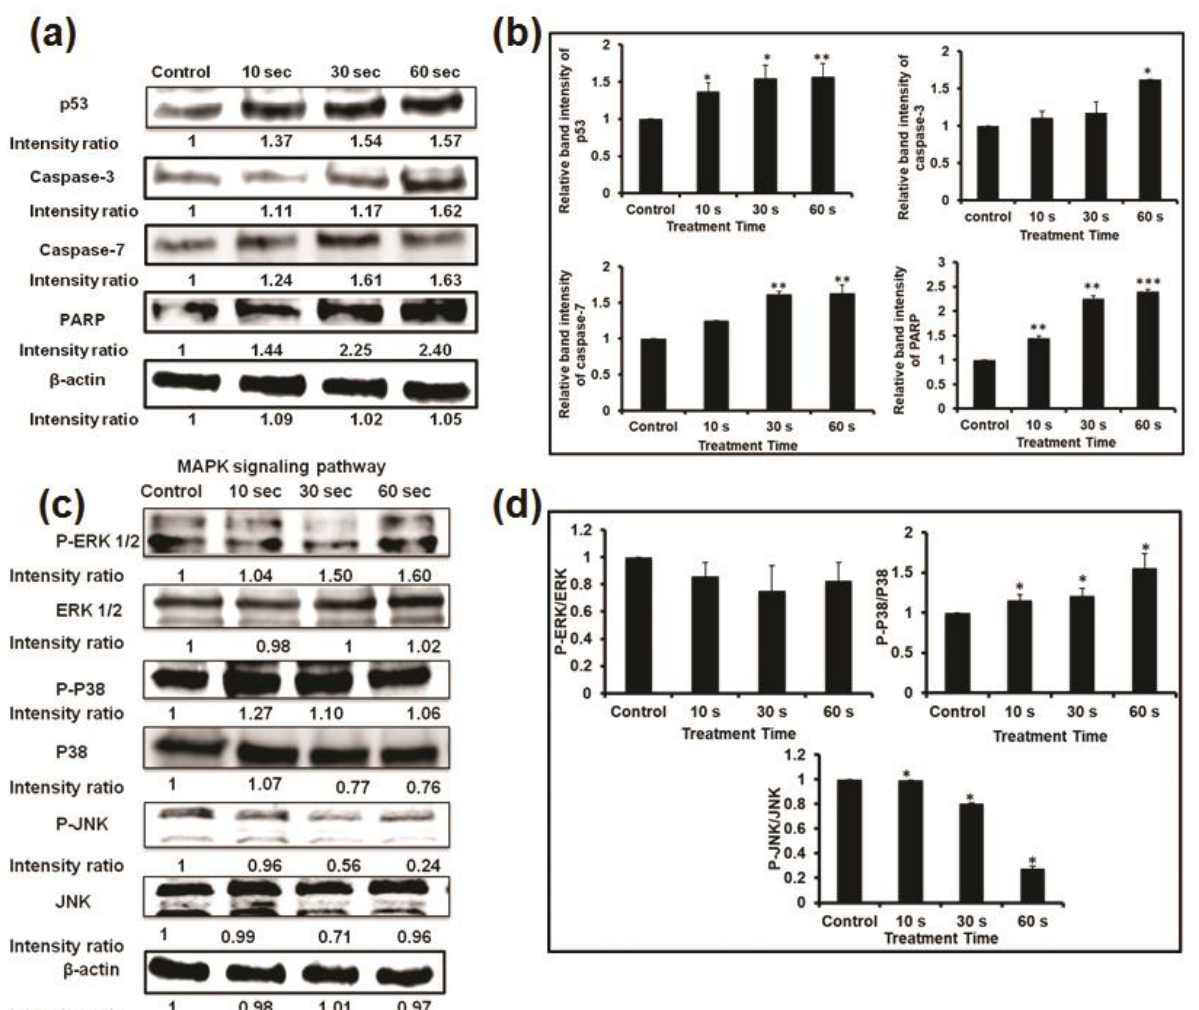
Figure 5. ( a ) Analysis of Western blot in U87MG cells for apoptosis-related protein expression. ( b ) Bar graph summarizing the apoptotic protein levels by relative band intensity. ( c ) Western blot analysis of the MAPK signaling pathway involved in the inhibition of the phosphorylation of ERK, p38, and JNK MAPKs by NBP-J treatment in U87MG cells. ( d ) Bar graph summarizing the phosphorylation of MAPKs. Data are presented as means ± SD of three independent sets of experiments. * p < 0.05, ** p < 0.01, and *** p < 0.001.